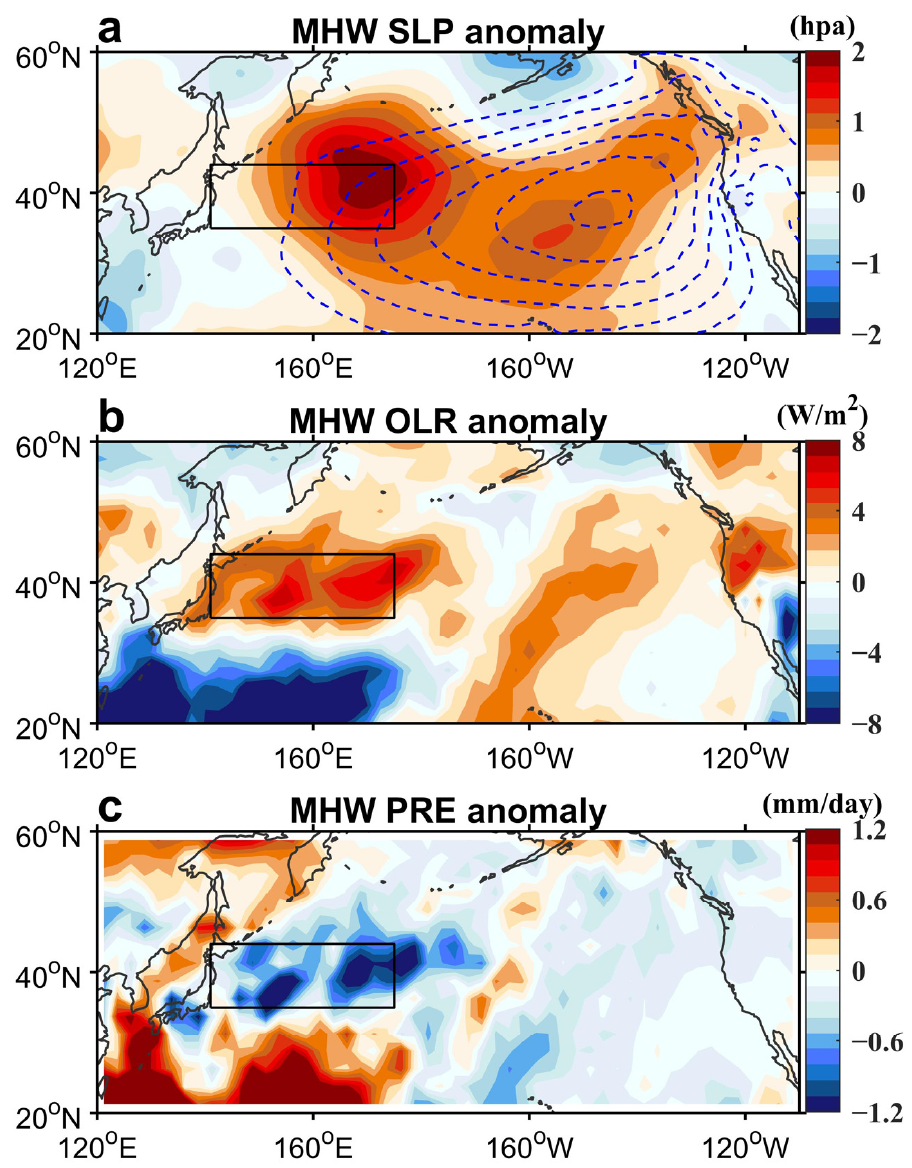
Figure 9. ( a ) Sea level pressure anomalies (SLP; shading) in KOE MHWs (1999, 2008, 2012, 2016). The blue dashed contours denote climatology SLP. ( b , c ) are the same as ( a ) but for the outgoing longwave radiation (OLR) anomalies and the precipitation (PRE)